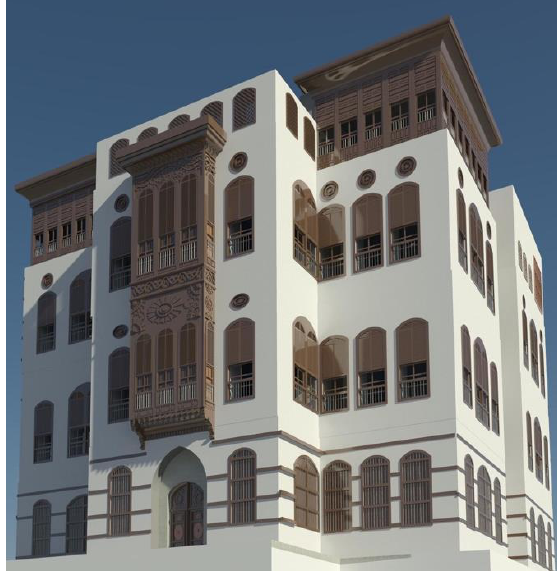
Figure 17. Nasif Historical House JHBIM model after the rendering in Autodesk Revit 2017.